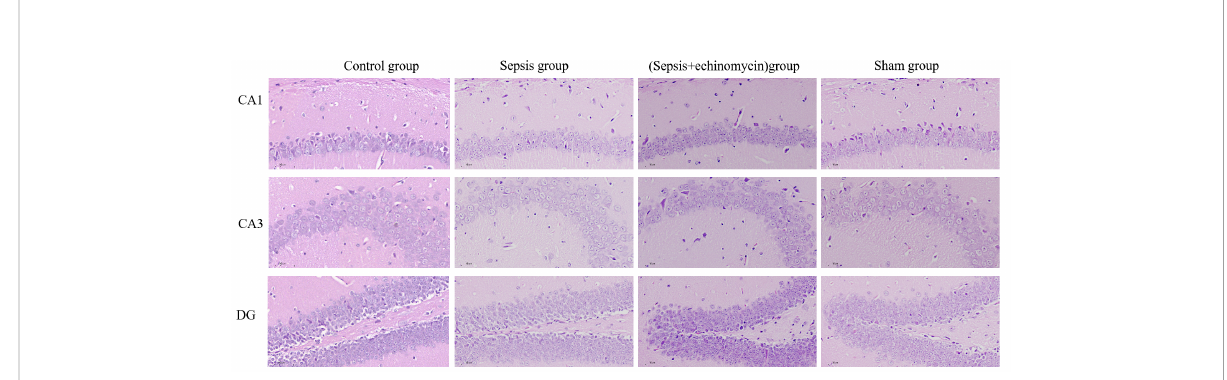
FIGURE 4 CLP increased CA1,CA3 and DG neuronal damages in the hippocampus of SAE mice. Compared with other three groups, mice in the sepsis group had signi fi cant edema of cells, decrease in pyramidal cells, and even lysis in the CA1, CA3, and dentate gyrus (DG) of the hippocampus region 24 h after